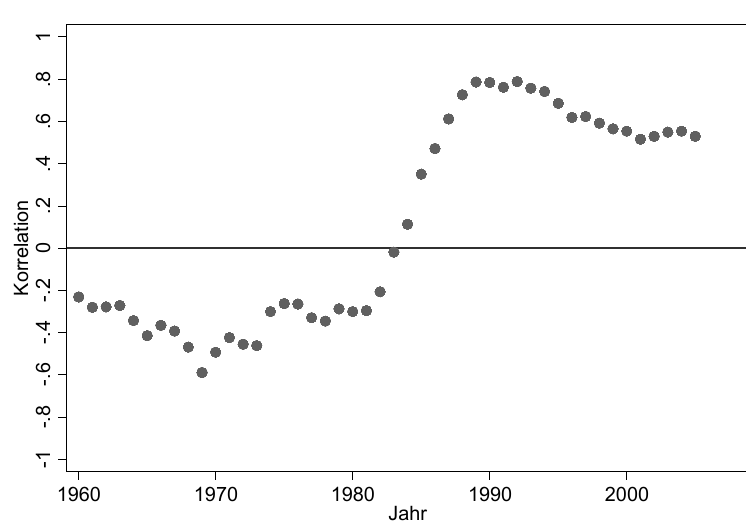
Daten: Siehe Anhang; eigene